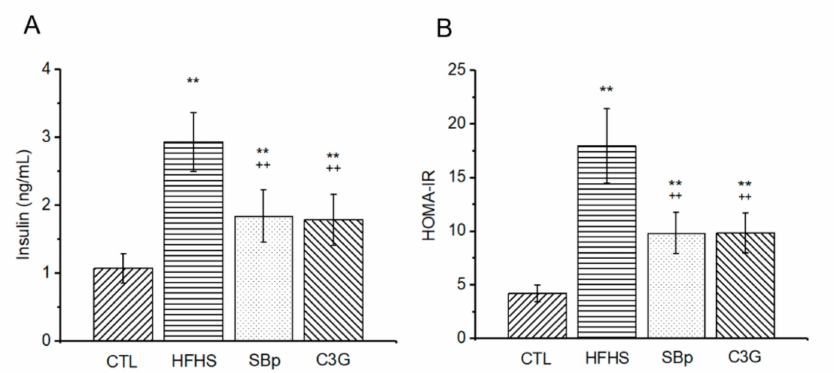
Figure 3. E ff ects of HFHS diets supplemented with C3G on insulin and insulin resistance in mice. The experimental regimen was described in the legend of Figure 1. The levels of fasting plasma insulin (ng / mL) were measured at indicated time points ( A ). Homeostatic model assessment of insulin resistance (HOMA-IR) was calculated according to the levels of glucose and insulin in the same plasma samples ( B ). Values are expressed as mean ± SD ( n = 8 / group). **: p < 0.01 versus the control (CTL) group; ++ : p < 0.05 or 0.01 versus the HFHS